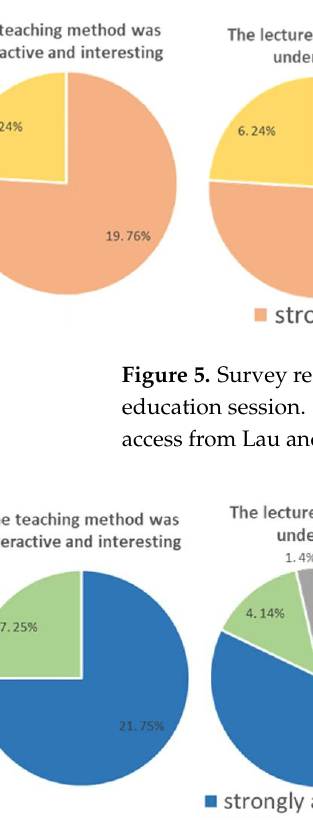
Figure 6. Survey response (number of students, percentage) of the 3D-printing group with regard to the education session. 3DPHM—3D-printed heart model. Reprinted with permission under the open access from Lau and Sun [49].